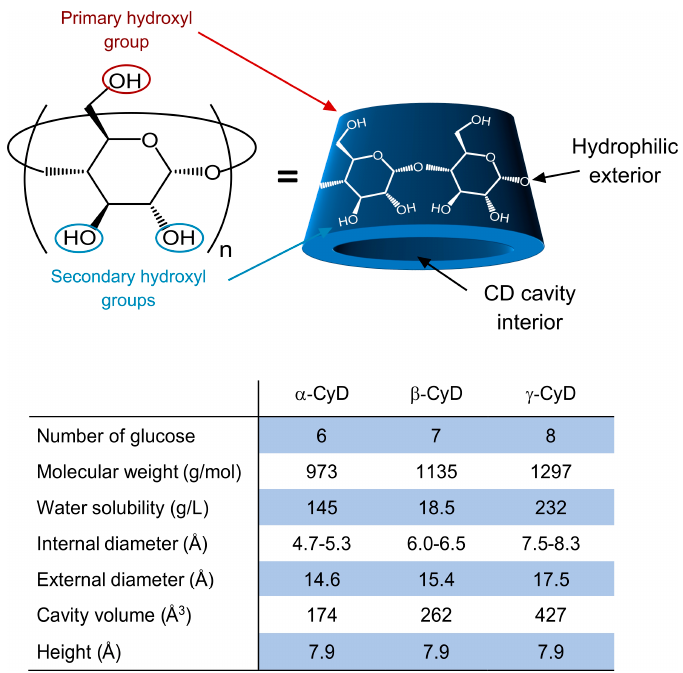
Figure 2. The chemical structure and the representative cartoon illustration of a native cyclodextrin (CyD) molecule in the 3D form. The general characteristics of CyD are given in the inset table [49]. Due to intermolecular hydrogen bonds, native CyD are not very water-soluble compounds.